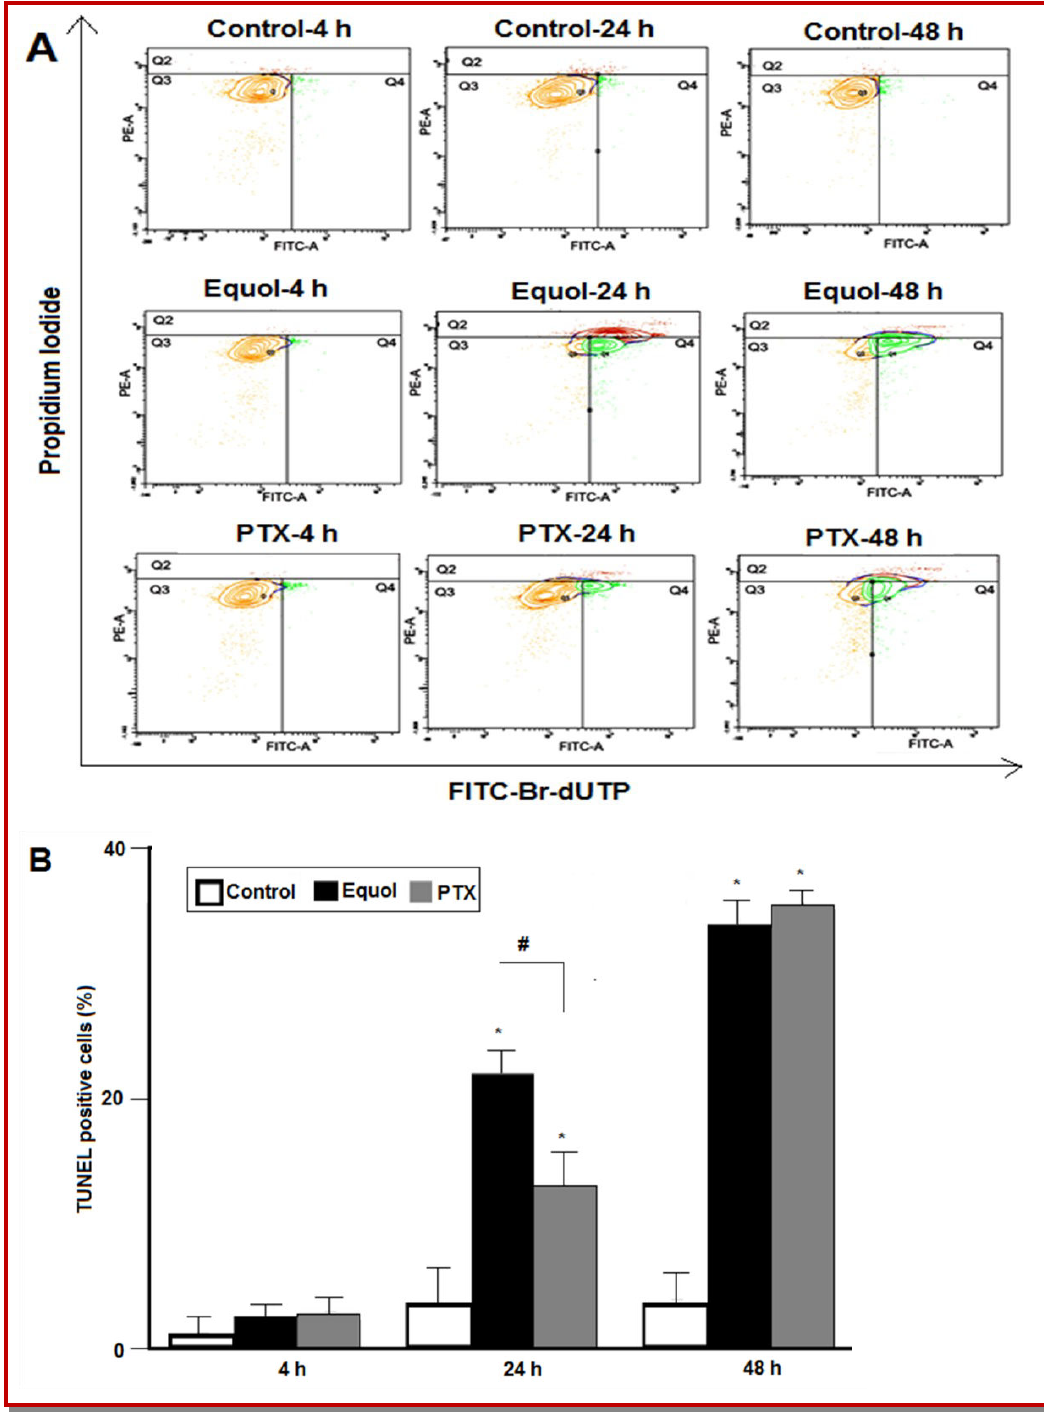
Figure 8 : Induction of apoptosis in SKOV-3 cells after treatment with IC 50 equol or PTX concentration evaluated by TUNEL assay. (A) Typical cytometric histogram obtained after 4 hours, 24 hours and 48 hours of incubation with the drugs. Q2-TUNEL positive cells, PI positive; Q3-TUNEL negative, PI negative cells; Q4-TUNEL positive, PI negative cells. (B) Quantitative results of the effect of the drugs on the level of TUNEL positive